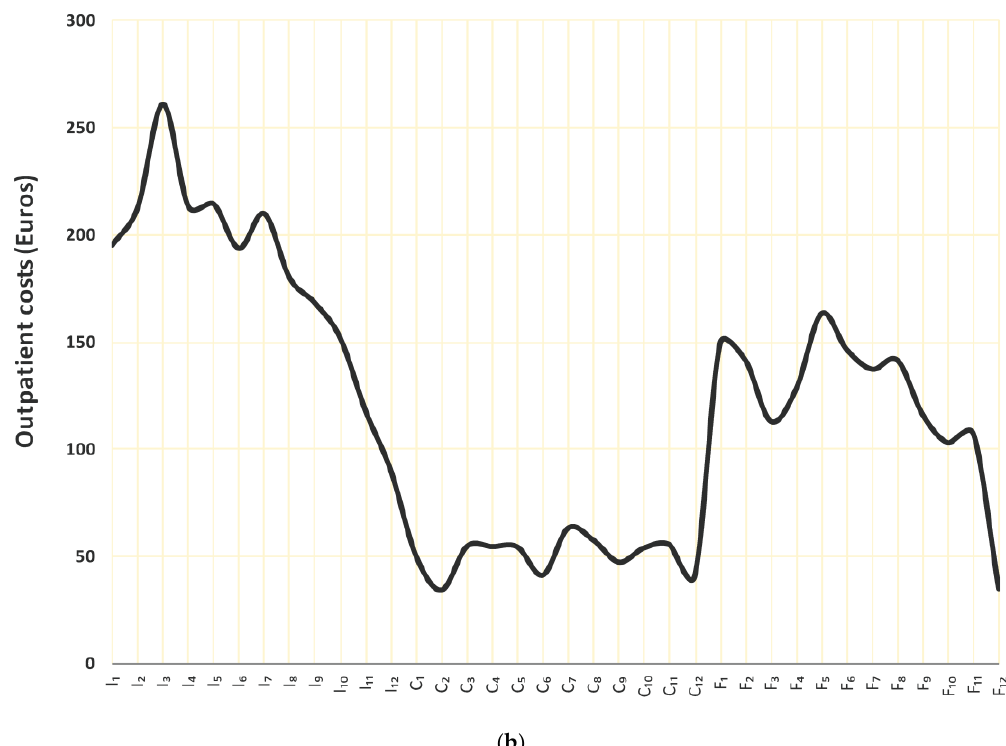
Figure 1. ( a ) Cost profile (or patient monthly average costs) due to hospitalization. Pool of CRs. ( b ) Cost profile (or patient monthly average costs) due to outpatient services. Pool of CRs.